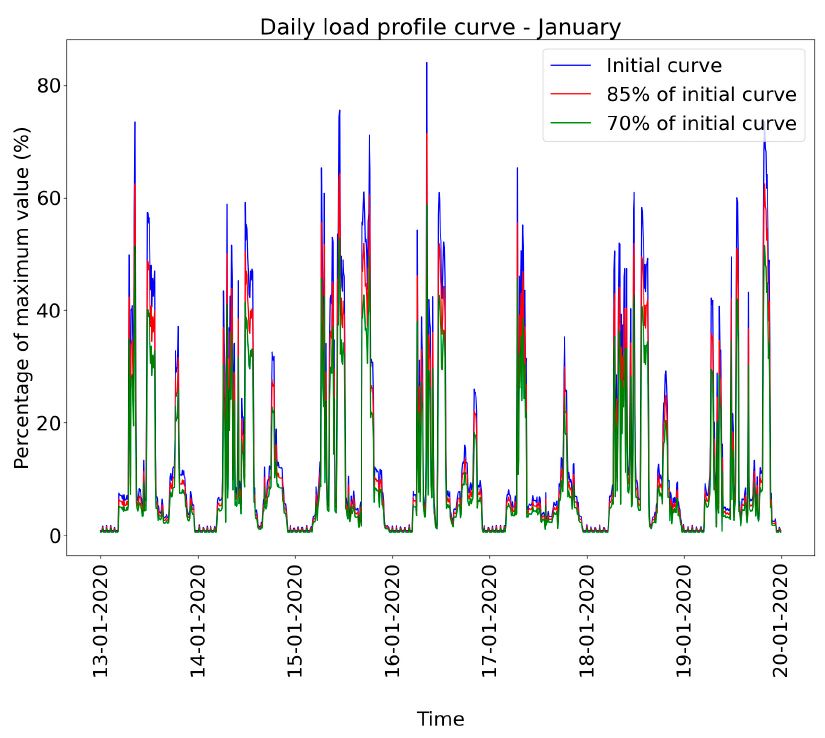
Figure A1. Load profile curve–January.